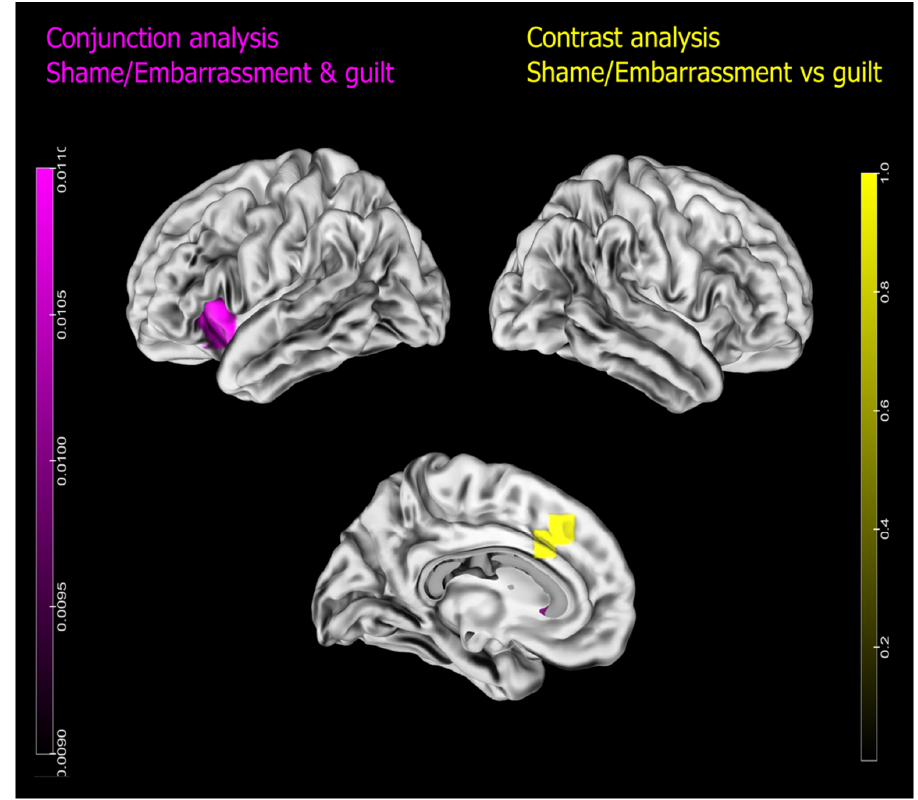
Figure 3. Contrast analysis results. In purple, conjunction analysis (shame/embarrassment and guilt); in yellow, specific activations of shame/embarrassment vs. guilt.